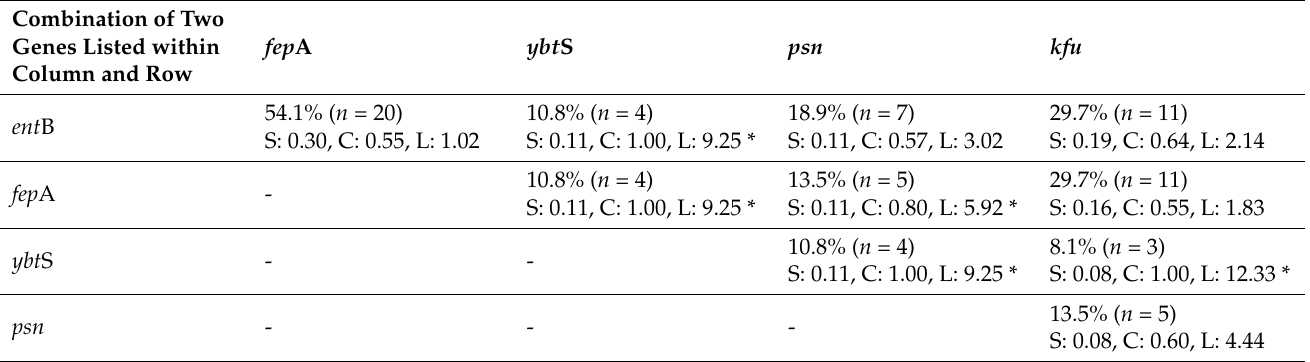
Table 3. Proportion (number) of polymerase-chain-reaction (PCR)-positive combinations of two iron- acquisition genes, and the association analysis 1 between the combination and the measurements of Klebsiella pneumoniae counts of >8 log 10 colony-forming units/mL on three incubation days in iron-deficient medium (basic KC3 ID